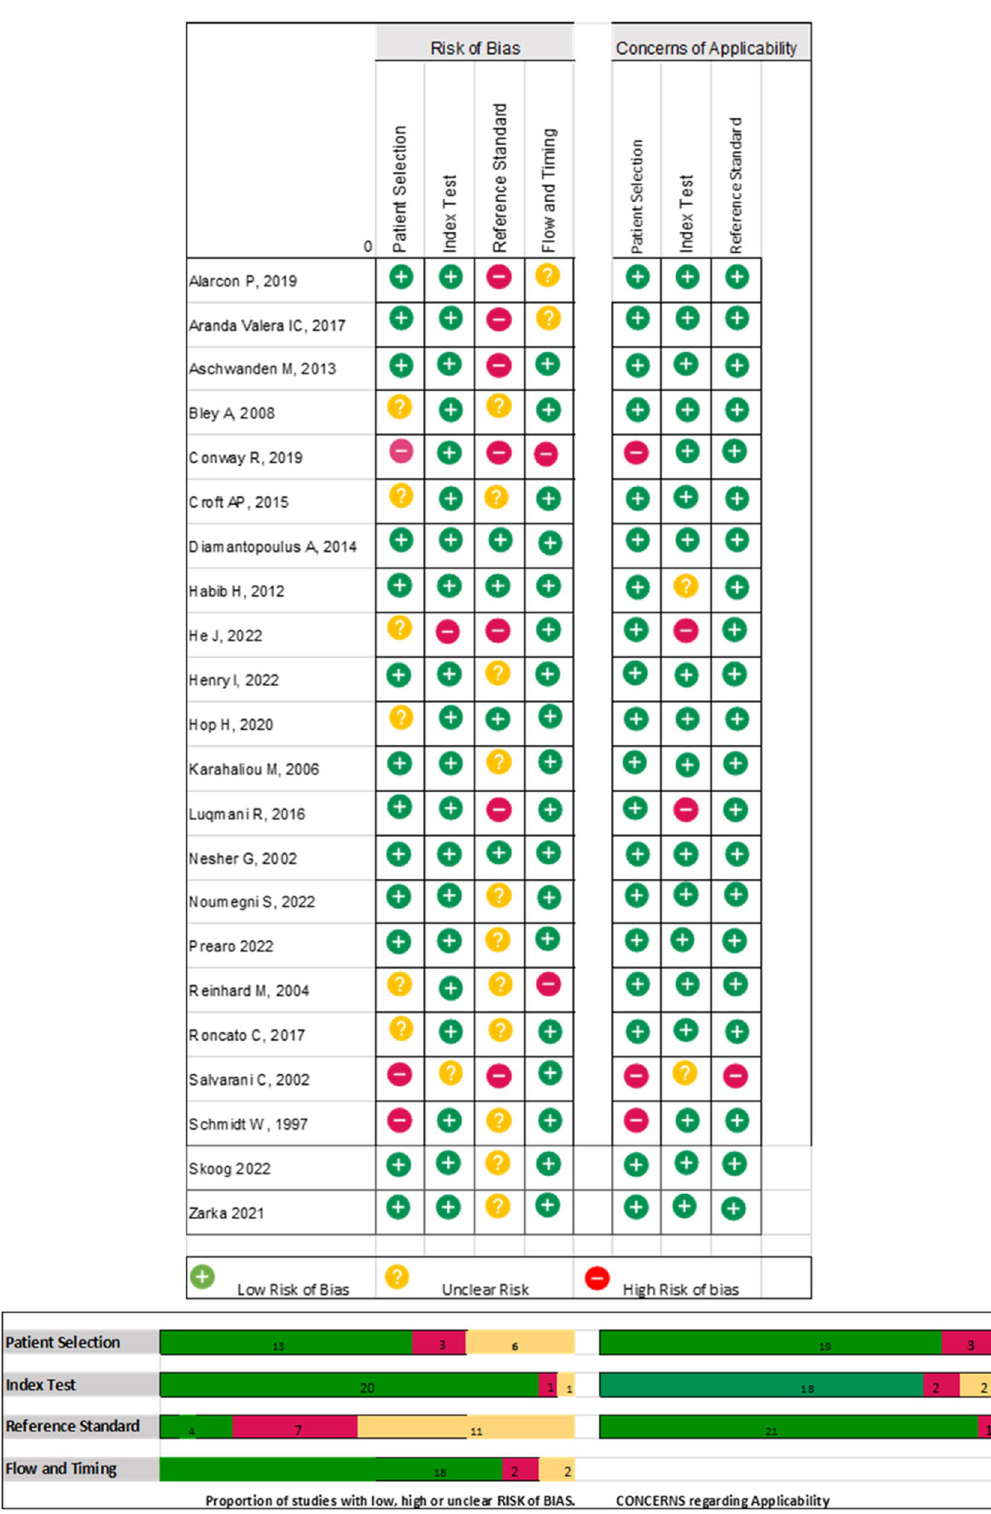
Fig. 2 Assessment of methodological quality of the studies included in this systematic review. Green signals mean low risk of bias; yellow signs mean uncertain risk of bias and the red signals mean high risk of bias. The domains include relevant QUADAS